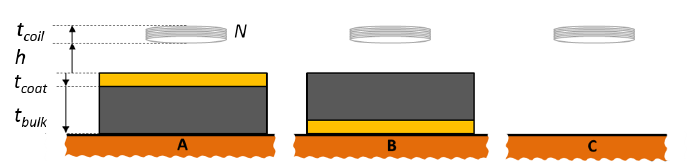
Figure 9. ECT schematic procedure for resistivity measurements. Measurements in configurations B versus C give information on bulk resistivity and lift-off h ; the measurement in configuration A versus B gives information on the coating resistivity. The thickness of the N -turns coil, of the coating and the bulk are also shown. The configuration C is taken with respect to the common substrate.